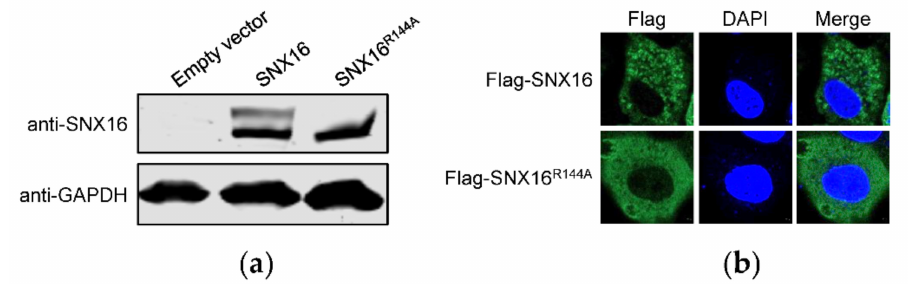
Figure 4. A single amino acid R144 is essential for the expression and distribution of SNX16. ( a ) A549 cells were transfected with plasmids expressing empty vector, pCAGGS-SNX16, or pCAGGS- SNX16 R144A , and then subjected to Western blotting with a mouse anti-SNX16 mAb. ( b ) A549 cells were transfected with plasmids expressing Flag-SNX16 or Flag-SNX16 R144A , followed by confocal microscopy with a rabbit anti-Flag pAb. Data are representative of two independent